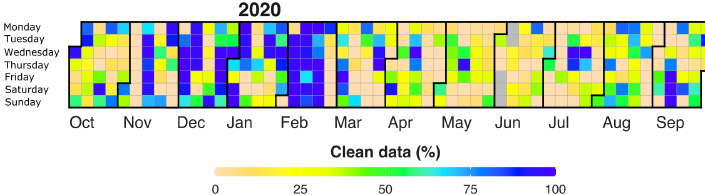
Figure A7. Percentage of clean particle number concentration data points per day during the MOSAiC expedition after application of the PDA. Missing data are indicated in gray and correspond to data removed when R/V Polarstern was within Svalbard’s 12 nautical miles zone. Please note that this figure is indicative only and does not necessarily reflect the percentage of clean data points collected by other instruments during the expedition.